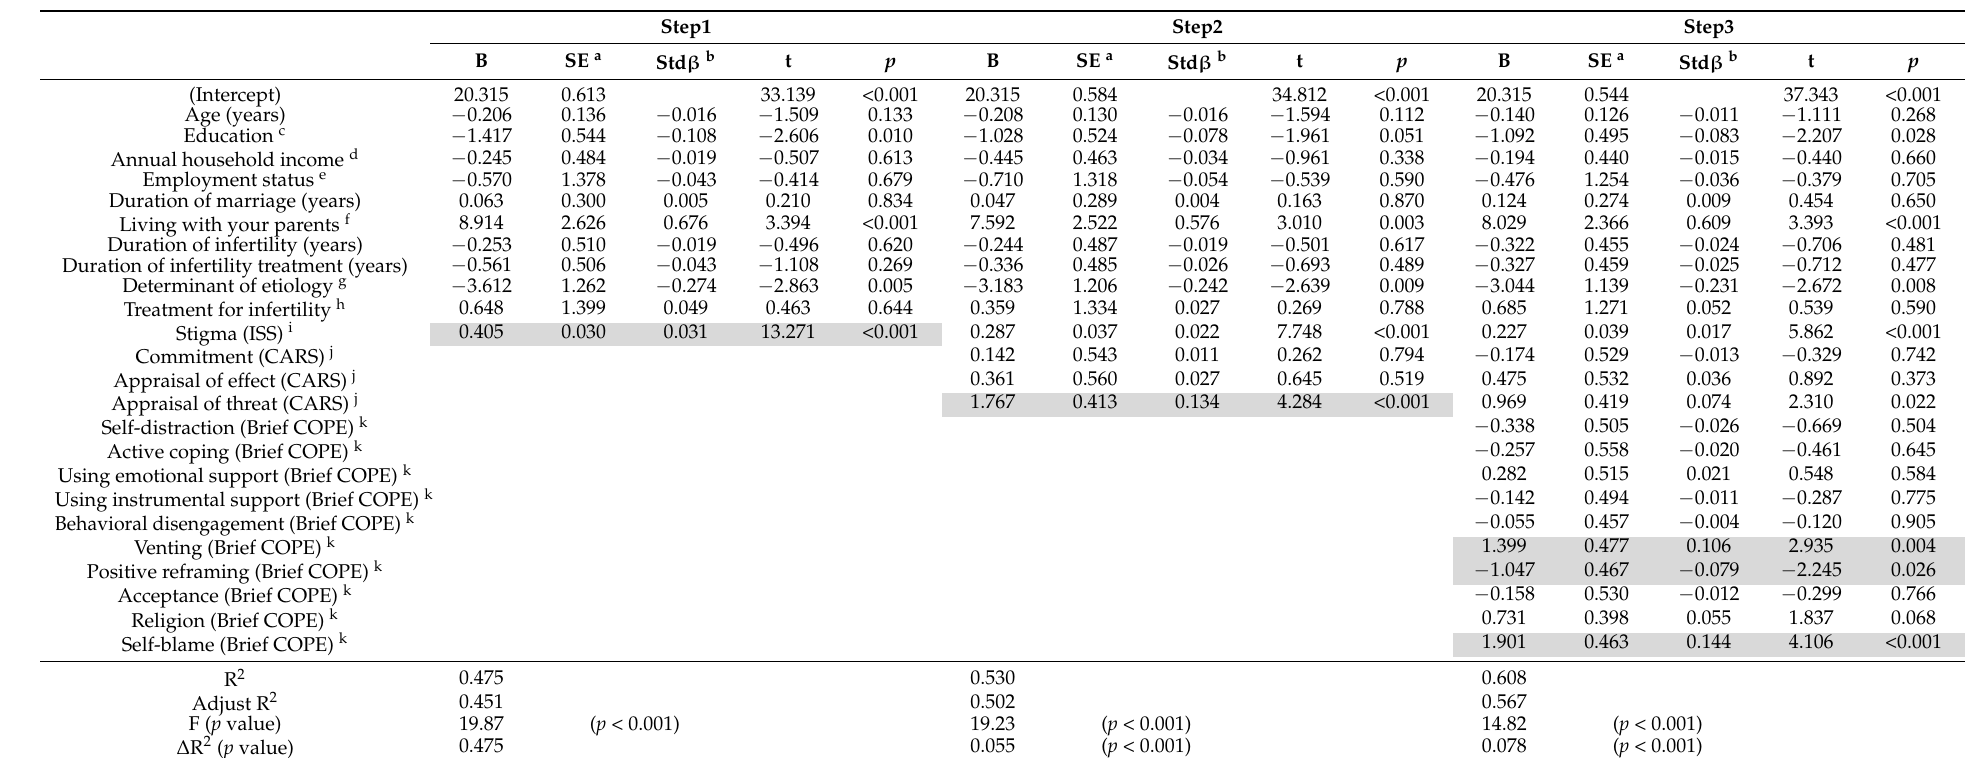
Table 2. Hierarchical linear regression predicting stress responses (SRS-18). ( n =